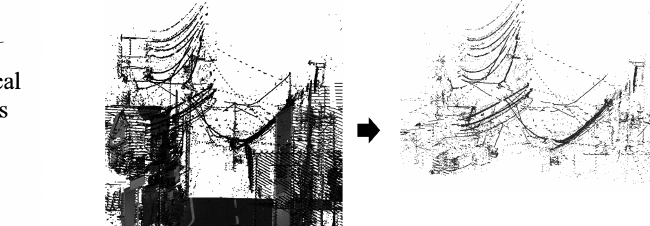
Figure 9. Detection of cylindrical objects